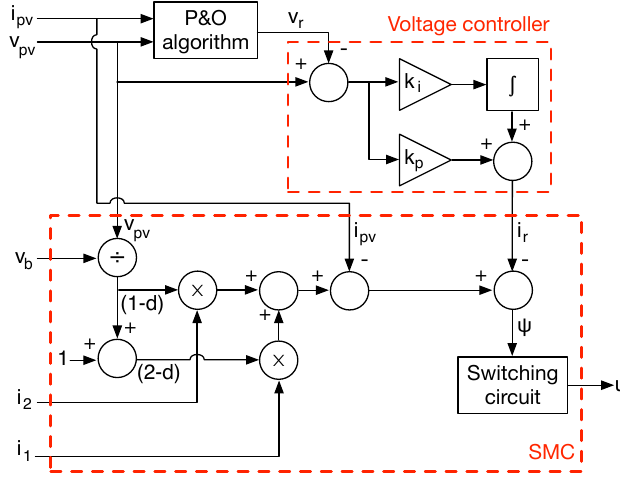
Figure 11. Implementation of the complete control structure.